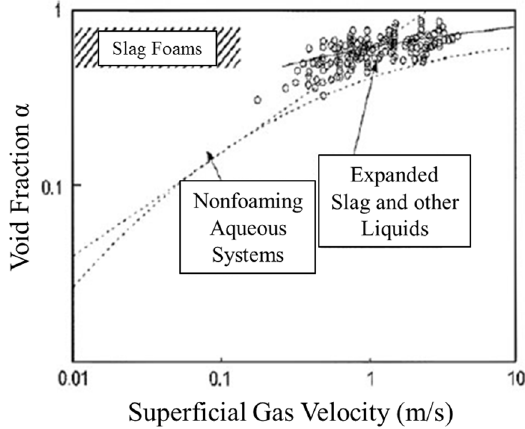
Figure 11: Summary of superficial gas velocity by fraction of gaps for foaming and non-foaming systems.